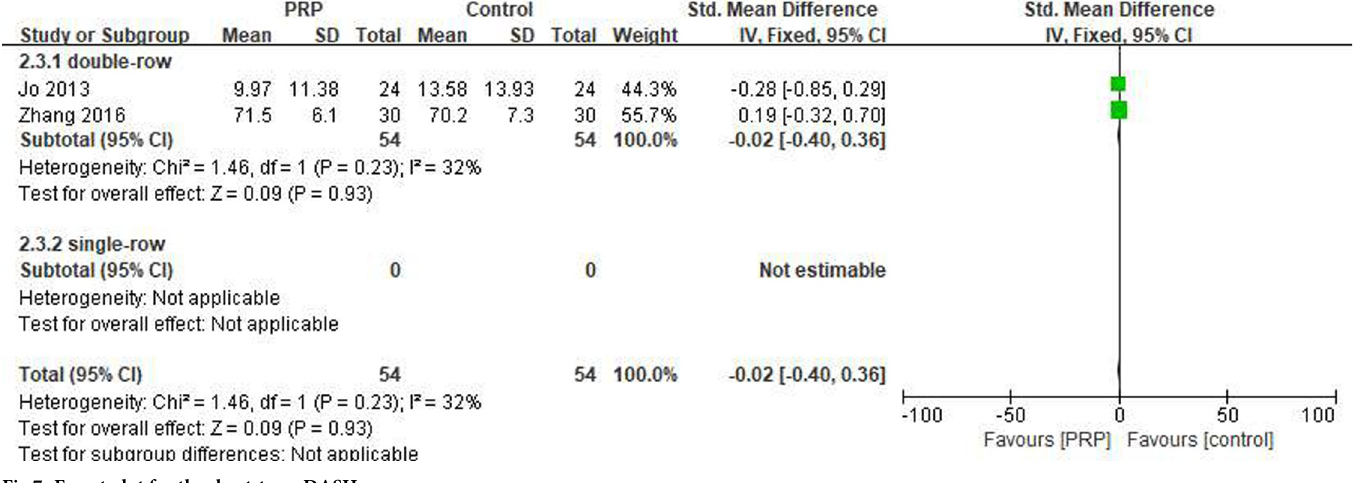
Fig 7. Forest plot for the short-term DASH